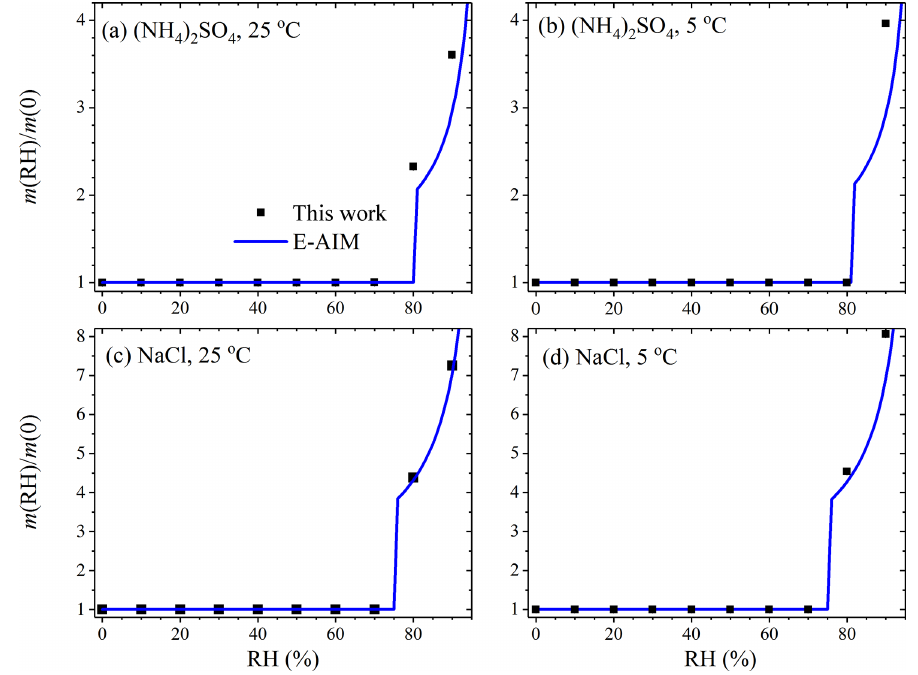
Figure 5. Comparison of mass hygroscopic growth factors measured in this work with these predicted by the E-AIM model. (a) ( NH 4 ) 2 SO 4 at 25 ◦ C; (b) ( NH 4 ) 2 SO 4 at 5 ◦ C; (c) NaCl at 25 ◦ C; (d) NaCl at 5 ◦ C. Please note that error bars are included, but they are too small to be clearly visible.